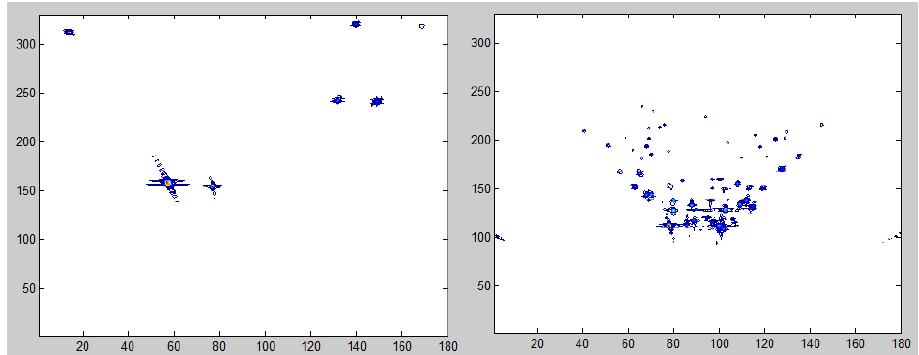
Fig. 4. Comparative images for continuous-waveform radiation with a different number of simulated reflectors: 10 on the left and 250 on the right; other conditions are the same: height is 100 m, horizontal speed is 100 m/s.